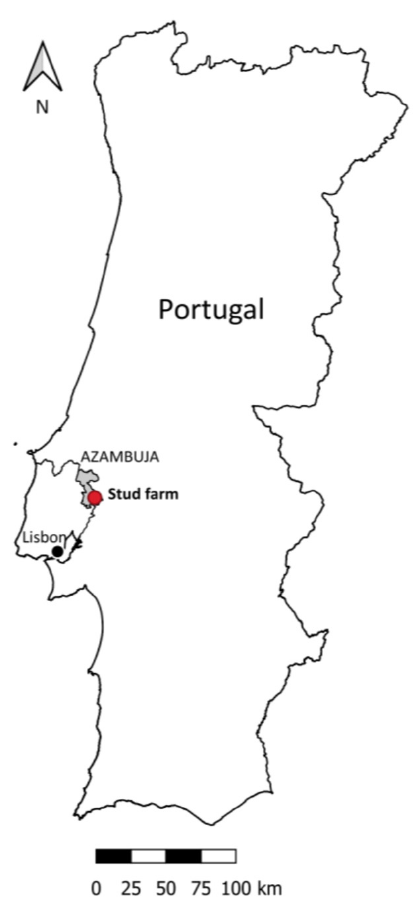
Figure 1. Location of the stud farm in the Azambuja region, central